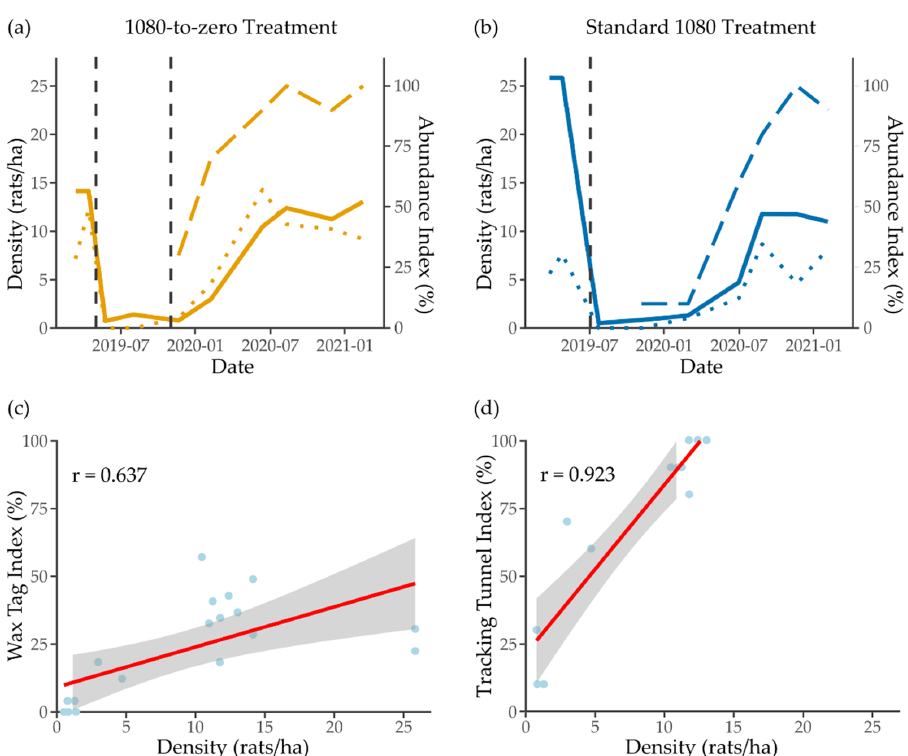
Figure 3. Density estimate (solid line), wax tag index (dotted line) and tracking tunnel index (long dashed line) for the ( a ) 1080-to-zero site and ( b ) standard site. Fitted least-squares linear regression (red) with 95% confidence interval (grey) and Pearson coefficient of correlation (r) between density estimates and ( c ) wax tag index and ( d ) tracking tunnel index.